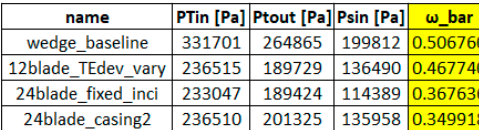
Figure 28. Pressure loss compared among the baseline wedge case and several optimums.